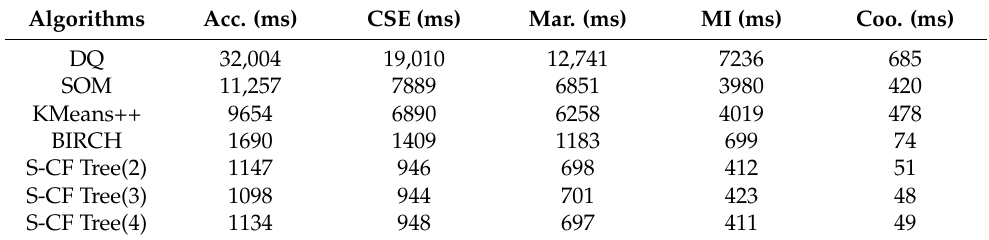
Table 1. Complexity tests (time) without feature